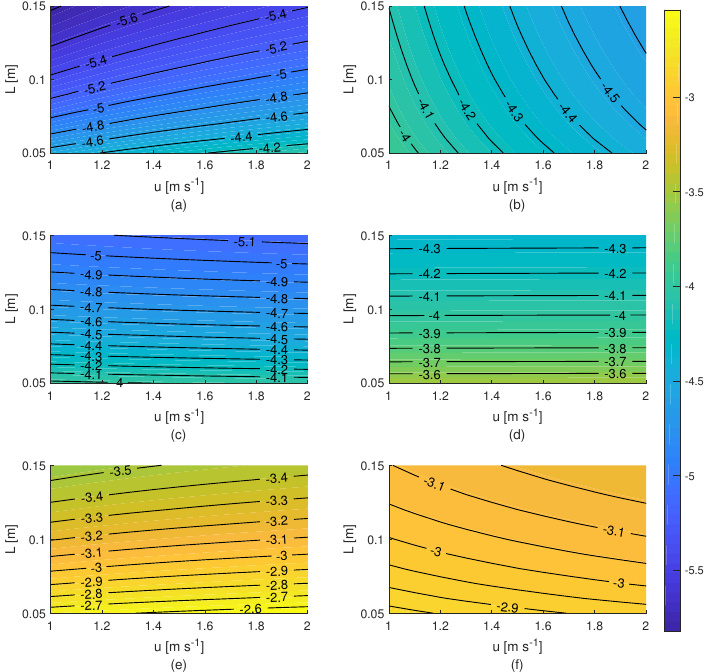
Figure A9. Difference between the outlet and inlet pad air dry-bulb temperature ( ∆ T ) as a function of inlet air velocity ( u ) and pad thickness ( L ) for the pad materials studied. ( a ) Cellulose. ( b ) Small co- conut shell (7.9–12.7 mm). ( c ) Big coconut shell (12.7–19.0 mm). ( d ) Burnt-clay bricks (12.7–19.0 mm). ( e ) Small pumice stones (34.9–45.0 mm). ( f ) Big pumice stones (45.0–55.5 mm).